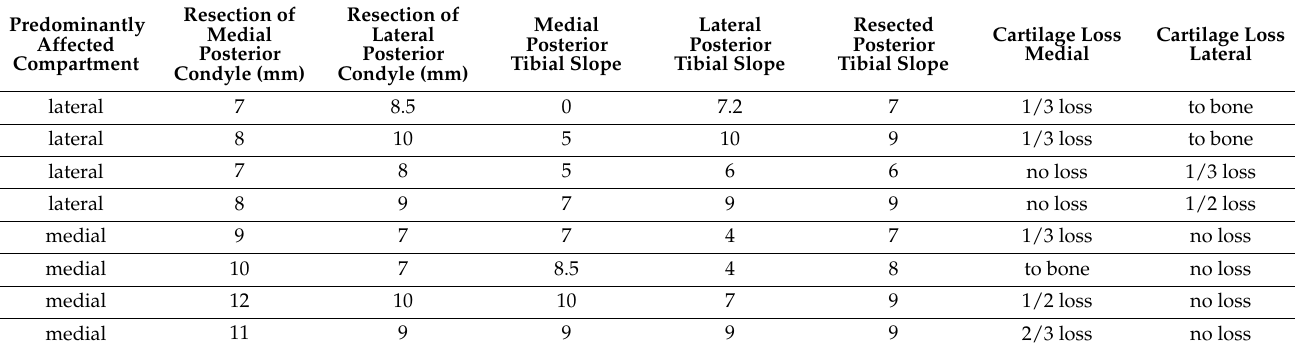
Table 2. TKAs having a reverse resection (higher resection at the affected compartment of the posterior femoral condyle). The resection (mm) as well as the posterior tibial slope of the medial, lateral tibia plateau and resected tibial surface are presented for each case. The thickness of the posterior condyles of the femoral component used in this study (CR, Attune TKA System, DePuy Synthes, Warsaw, IN) was 8